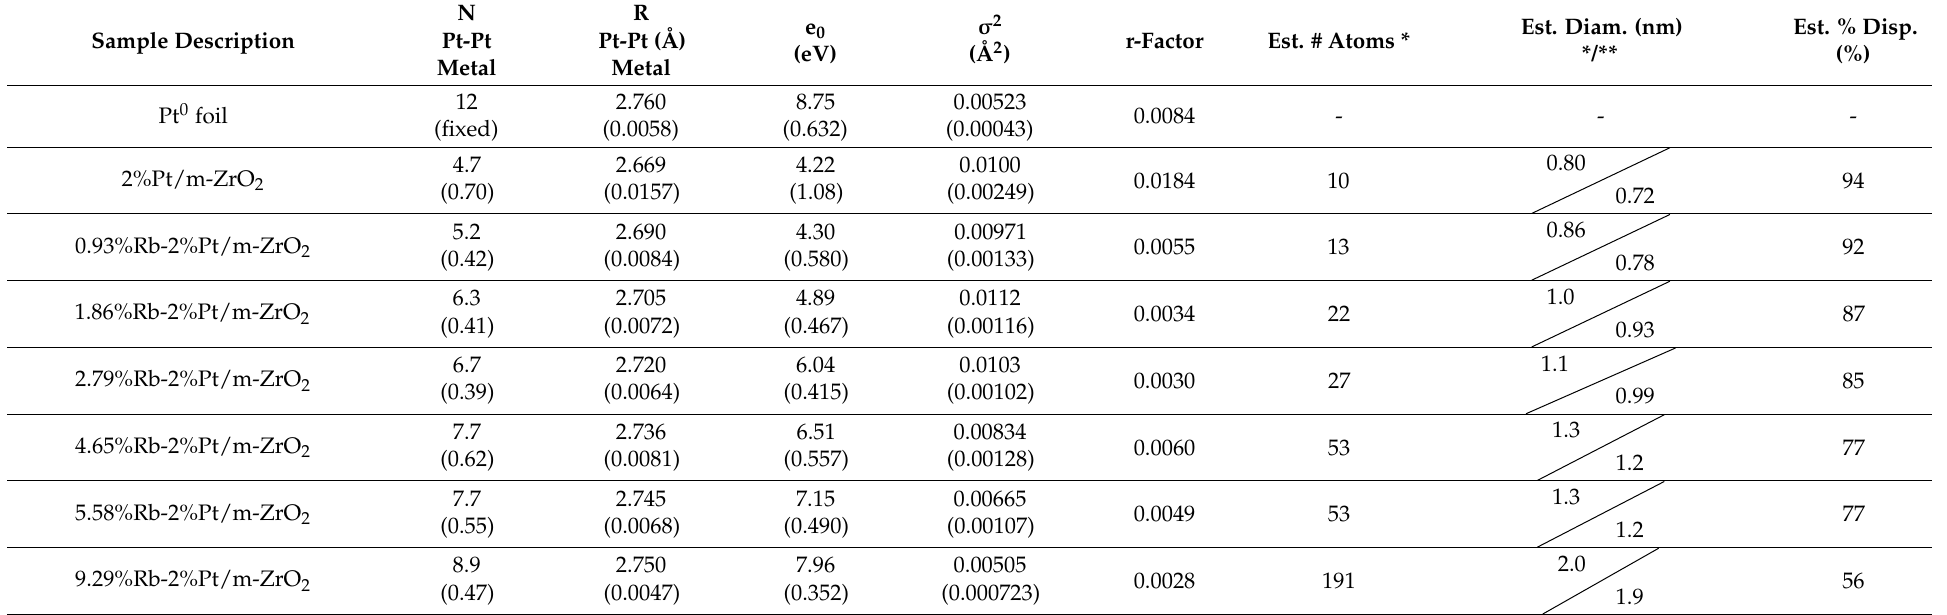
Table 2. EXAFS fittings * for Pt L-3 edge data for catalysts following reduction in 100% flowing H 2 for 2 h and cooling. Ranges: ∆ k = 3–10 Å − 1 ; ∆ R = 1.85–3.25 Å. S 02 was fixed at 0.90 as a first